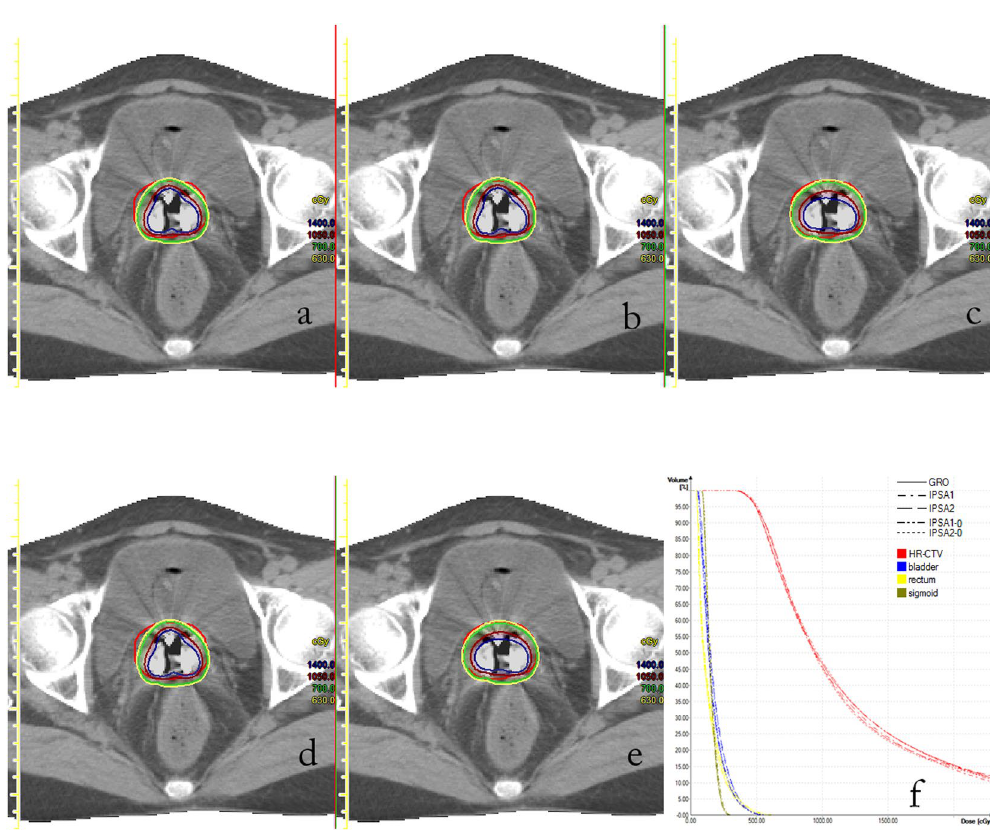
Figure 1. Example of transverse computed tomography images and dose-volume histogram from one patient for brachytherapy planned using ( a ) GrO, ( b ) IPSA1, ( c ) IPSA2, ( d ) IPSA1-0, or ( e ) IPSA2-0. ( f ) The dose- volume